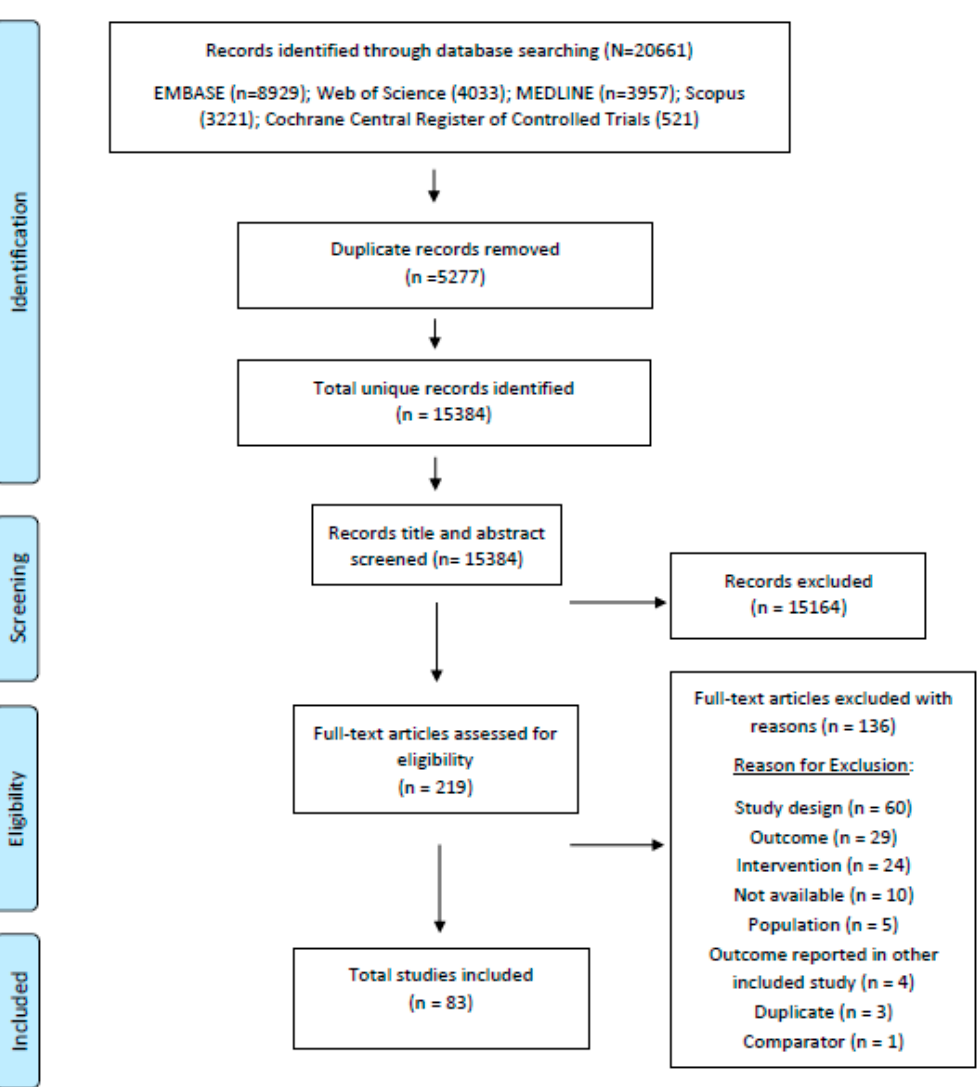
Figure 1. PRISMA Figure 1. PRISMA diagram.